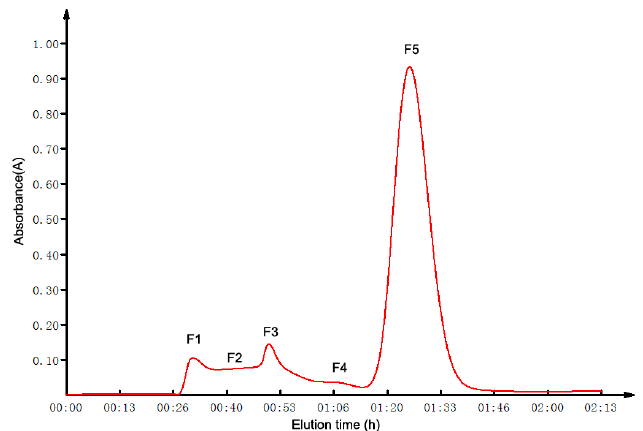
Figure 1. Gel filtration chromatography of the ultrafiltrate obtained under 0.1 Mpa pressure.